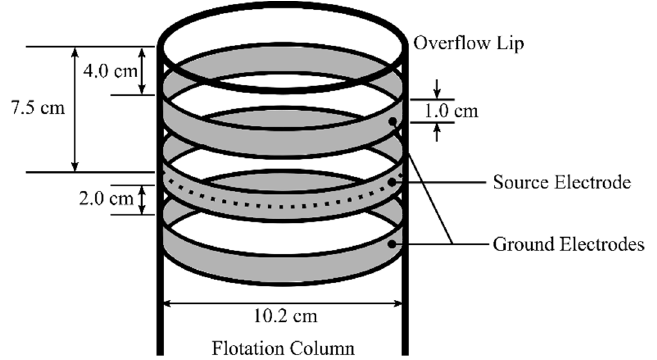
Figure 1. Schematic of the conductivity sensor used in experiment.